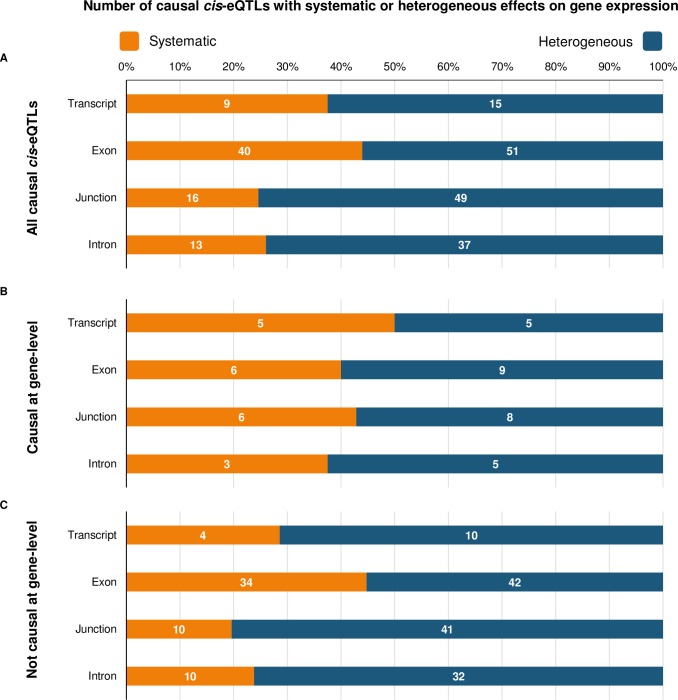
Number of causal cis-eQTLs with systematic or heterogeneous effects.(A) Using a modified test of heterogeneity that accounts for the dependency structure arising from within-individual and within-gene expression correlations, we distinguished causal cis-eQTLs that fitted either a systematic gene-model (orange) or a heterogeneous gene-model (blue) per quantification type. The full results of this analysis are found in S7 Table. Numbers represent the total number of SNP-gene associations per quantification type. (B) Causal cis-eQTLs that are also causal cis-eQTLs at gene-level. (C) Causal cis-eQTLs that are not causal cis-eQTLs at gene-level.